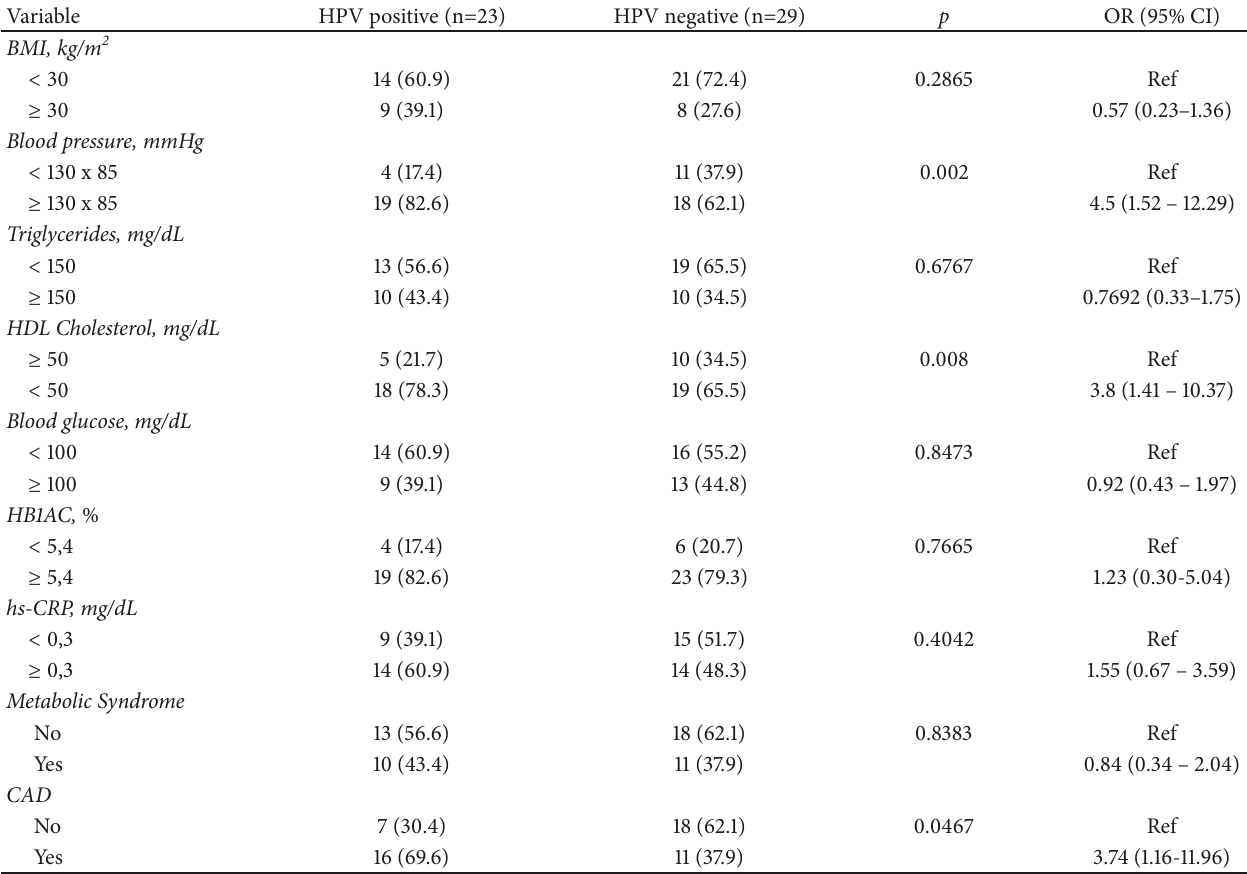
Table 2: Association between clinical variables of participants and HPV status.